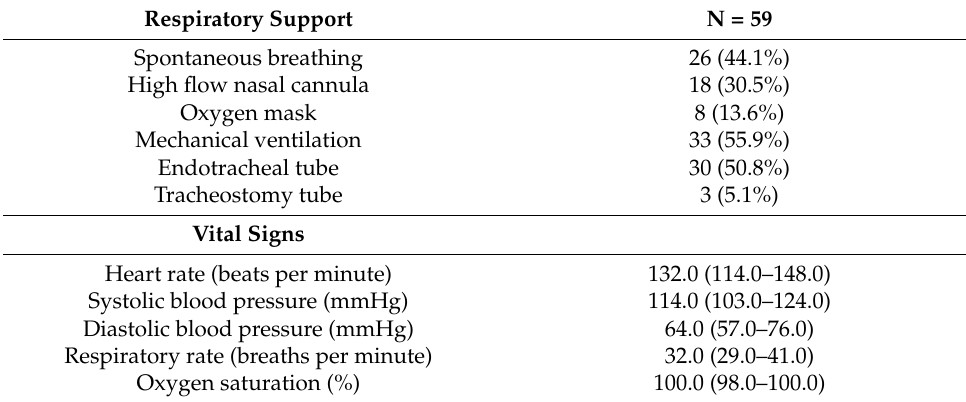
Table 2. Respiratory support and vital signs at